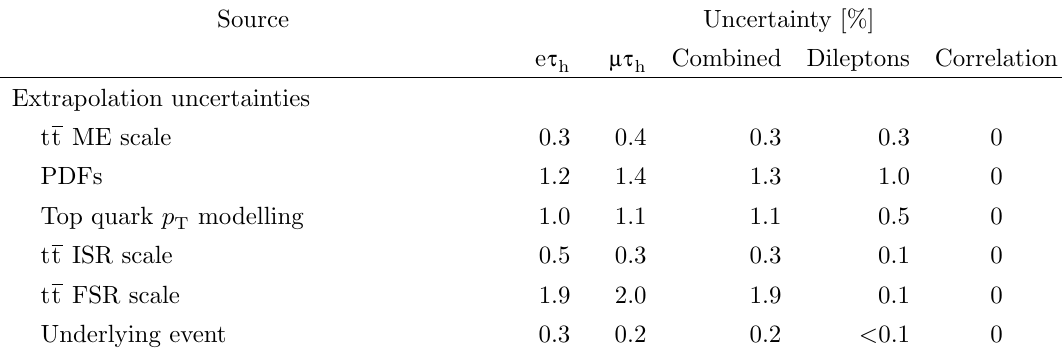
Table 2. Systematic and statistical uncertainties determined from the (cid:12)t to the data in the e t mt h (cid:12)nal states, and their combination. Uncertainties are grouped by their origin: experimental, theoretical, normalization, and extrapolation. The uncertainties in the measurement in the dilepton (cid:12)nal state [14] used in the partial width ratio estimate are also quoted (column \dileptons"), where the asymmetric extrapolation uncertainties are symmetrized by adding them in quadrature. As both measurements use the same data, some uncertainties in the ‘ t are correlated, as shown in the last